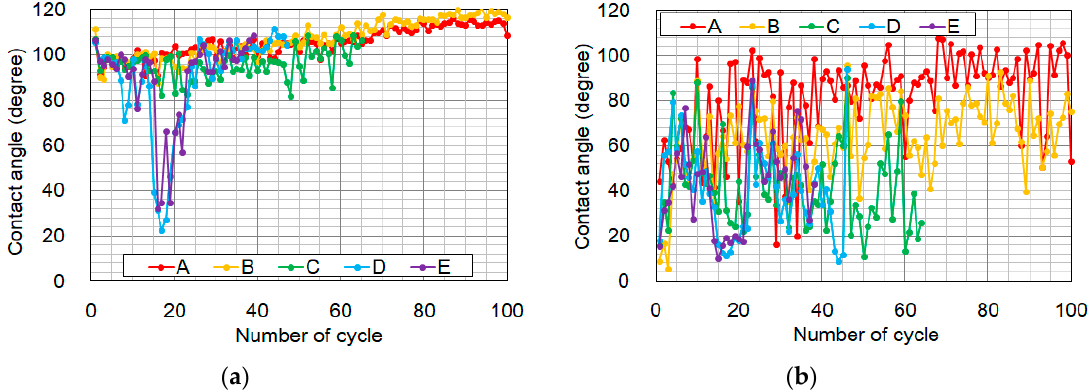
Figure 4. Change in contact angle with number of cycles in 100-cycle test with gap spacing 2 mm. ( a ) Just before commencement of voltage application. ( b ) Just after voltage interruption.